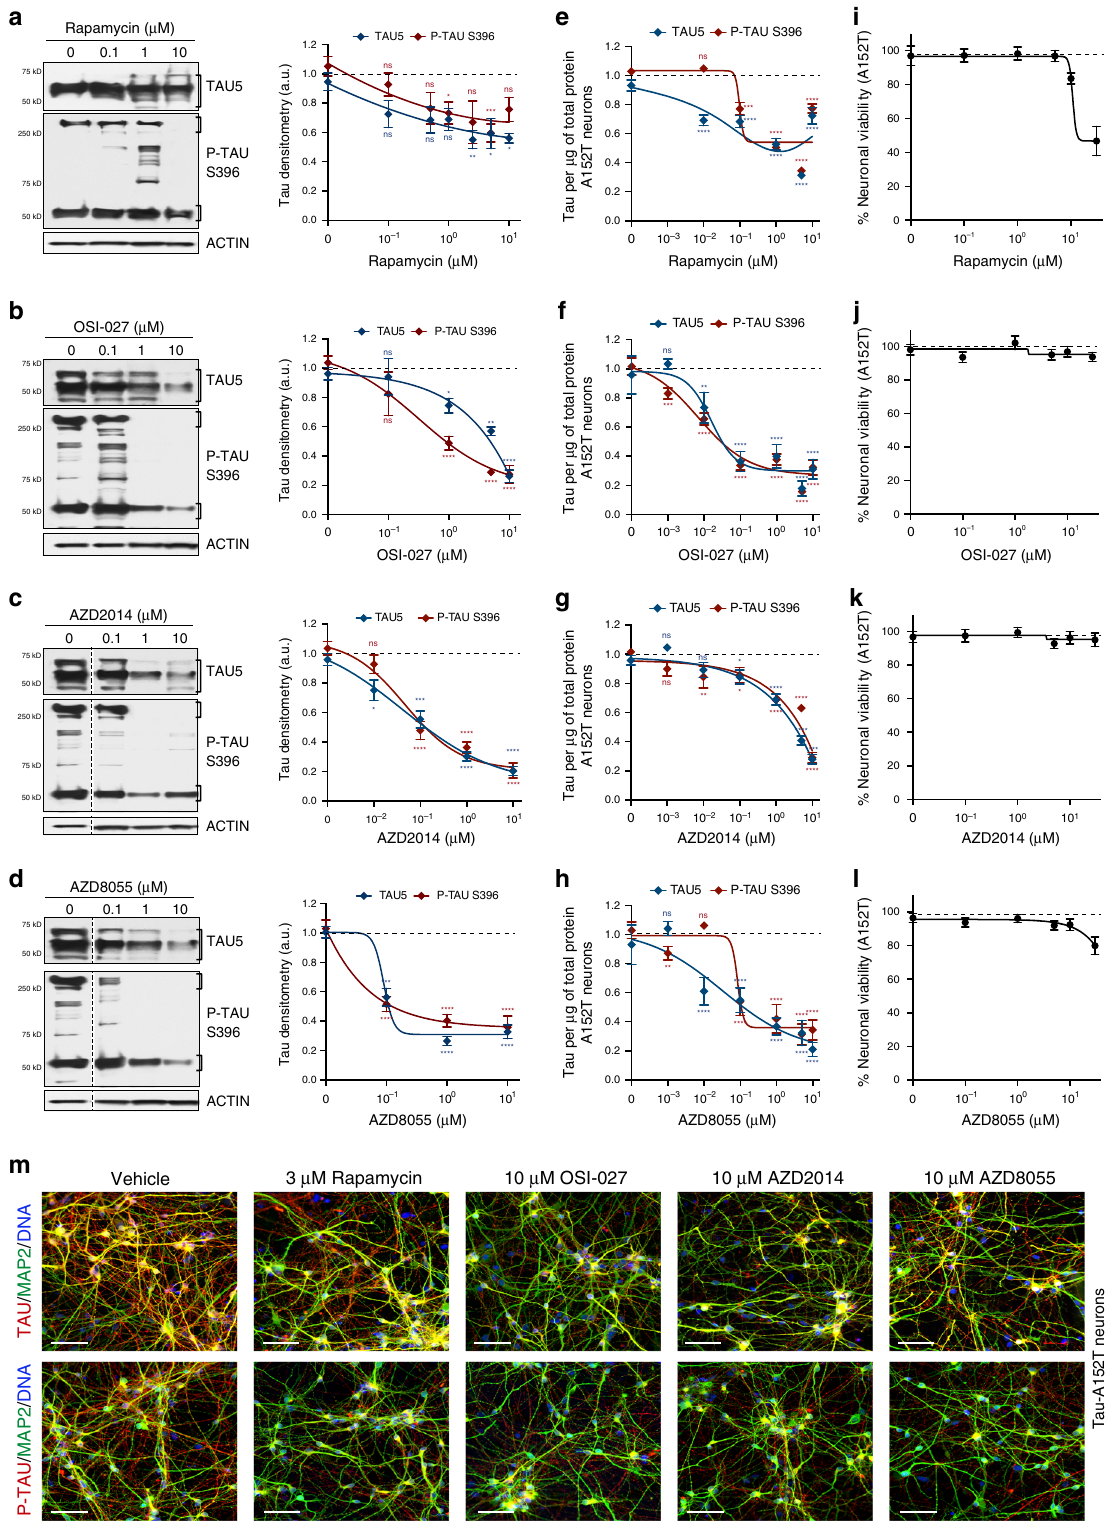
(Fig. 2i – l), except for a ~20% decrease by AZD8055 at 30 μ M. Only rapamycin became toxic at concentrations ≥ 5 μ M, leading to 50% loss of viability (Fig. 2i). A152T neurons treated for 24 h with mTORi at the concentration for maximum tau reduction were stained for total tau or PHF1 P-tau (Fig. 2m, red) in combination with the neuronal marker MAP2 (Fig. 2m,